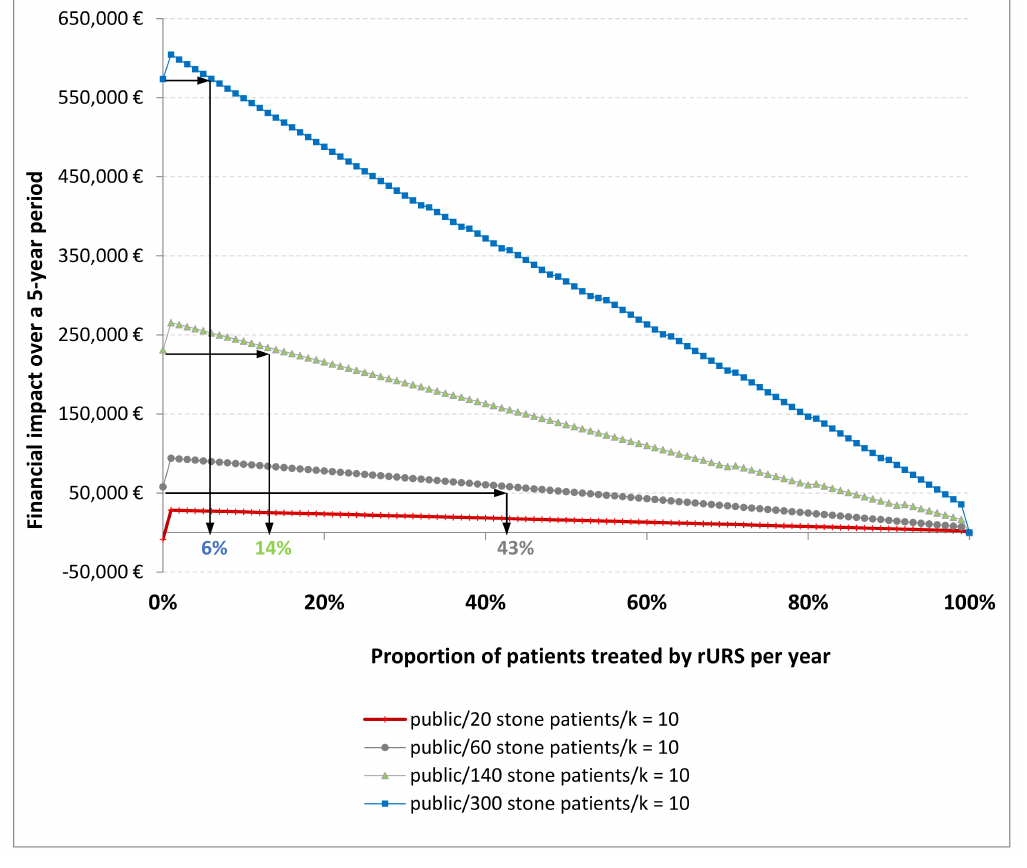
Figure 1. Graphical representation of the cut-off value for different types of facility. Note: The cut-off value can be read on the x-axis by projecting the value of the financial impact of switching completely to sURS use on the curve. For a public institution with 20 stone patients to be treated and 200 endoscope sterilization procedures (k = 10), the financial impact of switching to sURS use was negative (deficit reduction between costs and revenues) so any HS would not be profitable. For institutions with 60, 140 and 300 patients, the cut-off values were 43%, 14% and 6%, respectively, so the HS was more profitable than 100% sURS